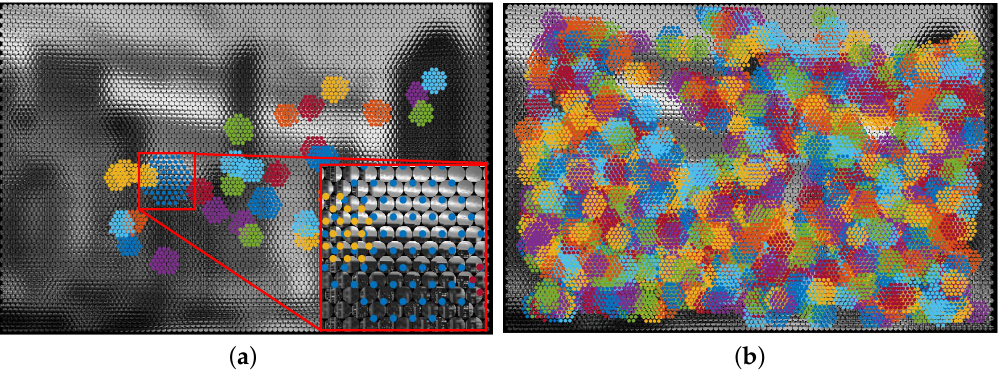
Figure 11. Examples of detected results on simulated raw images. ( a ) Error detected result using 2-layer CPSFS. ( b ) Detected result using 8-layer CPSFS. The results in panels (a,b) are based on the same raw image. Note that different colors in figures are used to distinguish the features projected by diverse plenoptic disc